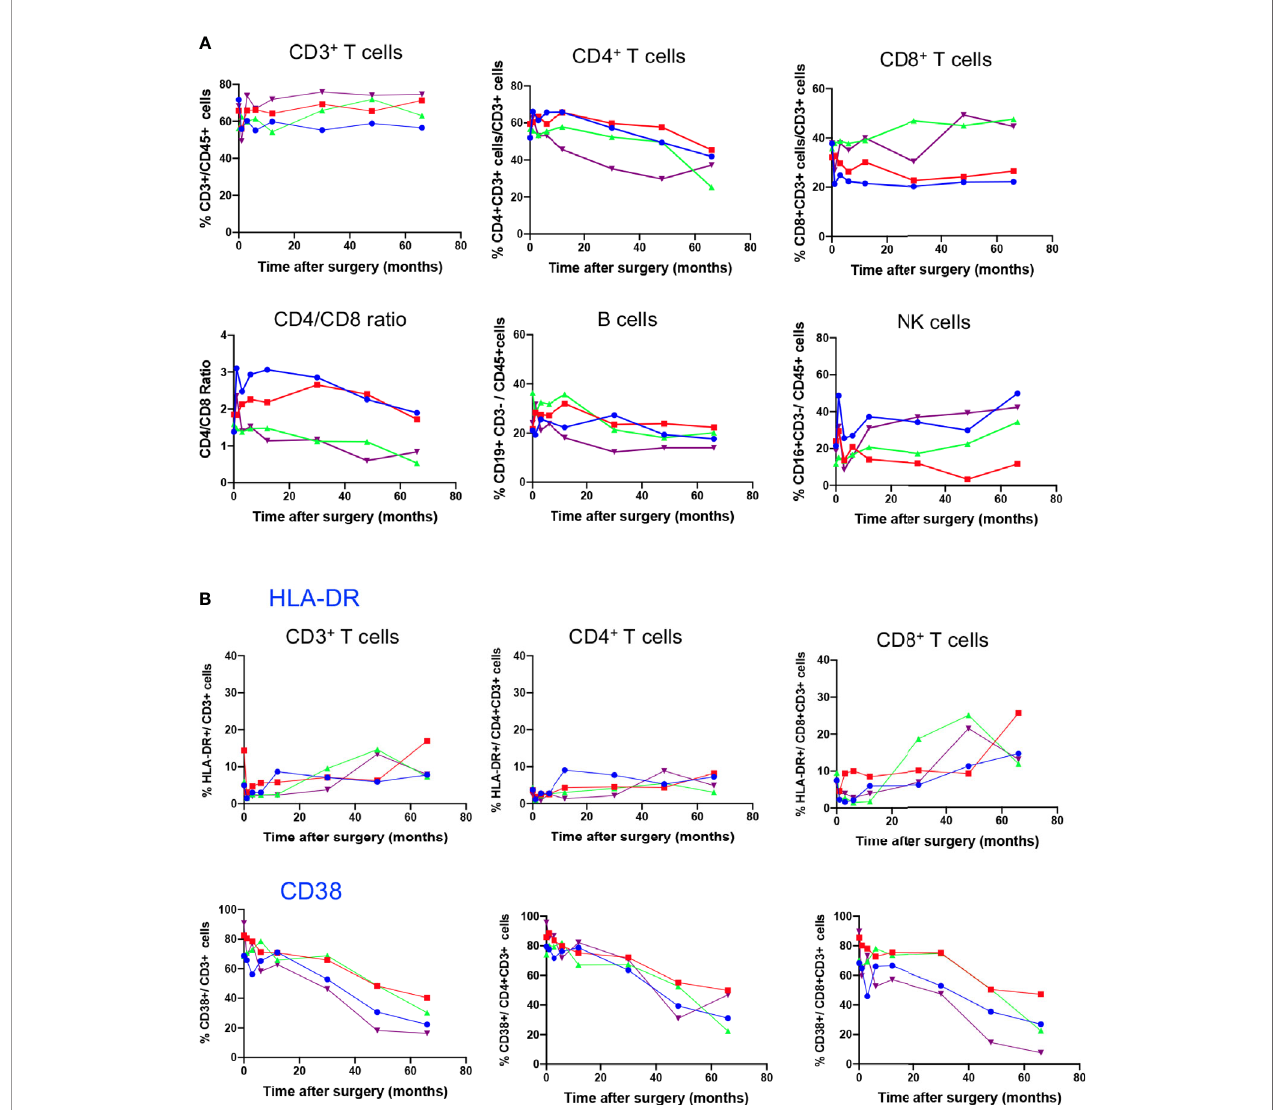
FIGURE 1 | Time course distribution of lymphocyte subsets and expression of activation markers. (A) Lymphocyte subset enumeration was performed at indicated time points on whole blood by polychromatic fl owcytometry. Cell subsets were characterized on gated CD45 + cells through the expression of CD3 (CD3 + T cells), coexpression of CD3 and CD4 (CD4 + T cells) or CD3 and CD8 (CD8+ T cells), CD3 neg CD19 + (B cells) and CD3 neg CD16 + (NK cells). Individual values of each patient (P1, P2, P3, P4) are shown. (B) The expression of the activation markers HLA-DR and CD38 on indicated T cell subsets was assessed on whole blood by polychromatic fl owcytometry at indicated time points after gene therapy. Individual values of each patient (P1, P2, P3, P4) are